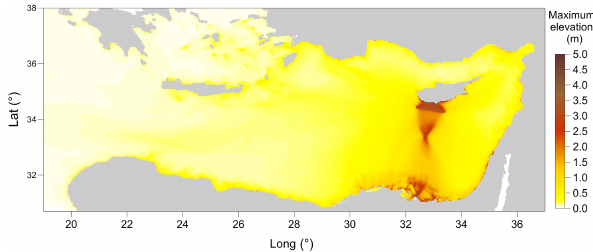
Figure 11. Sea surface maxima in grid 1 for the tsunami generated by the Cyprus Arc (CA) earthquake (see Table 1 for details).